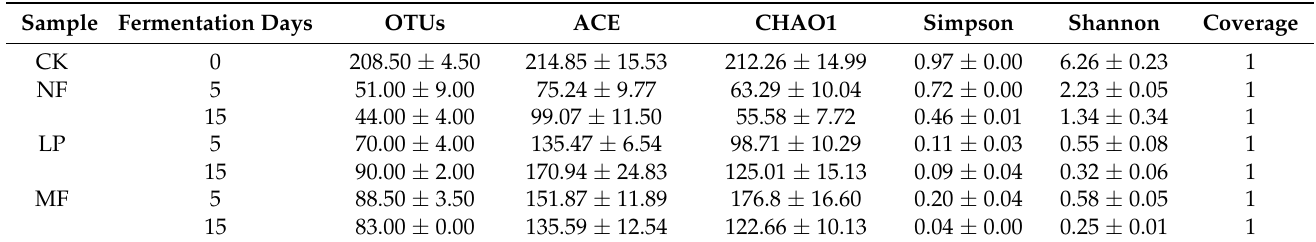
Table 1. Alpha diversity index statistics of different fermented Suanyu samples.